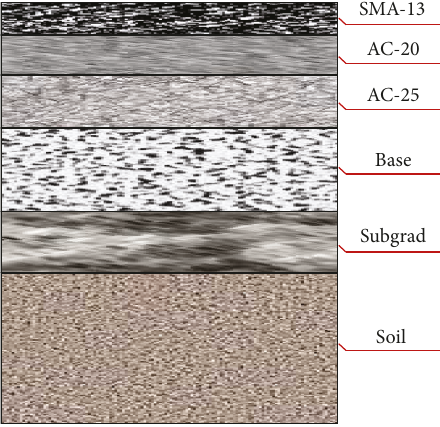
Figure 2: Asphalt pavement linear elastic. The parameters of each layer are listed in